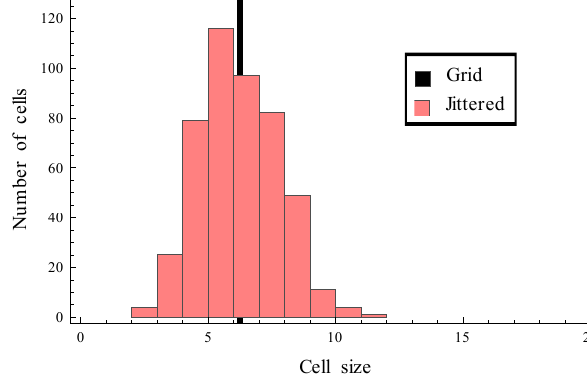
Figure 6. Tile size distribution for the jittered tile size distribution of the reanalysis data together with the grid